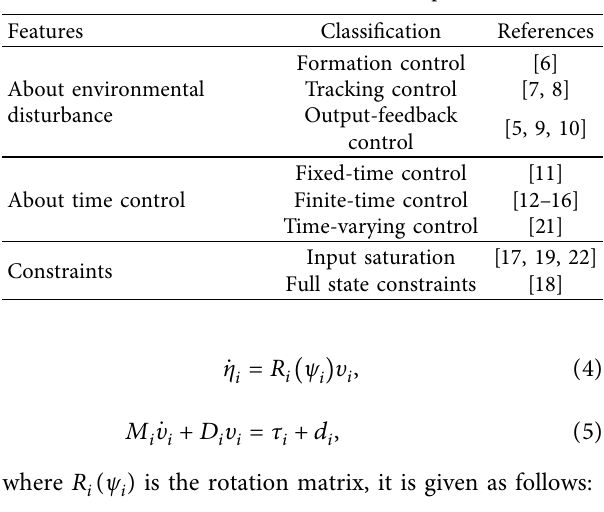
Table 1: Recent works on consensus problems.